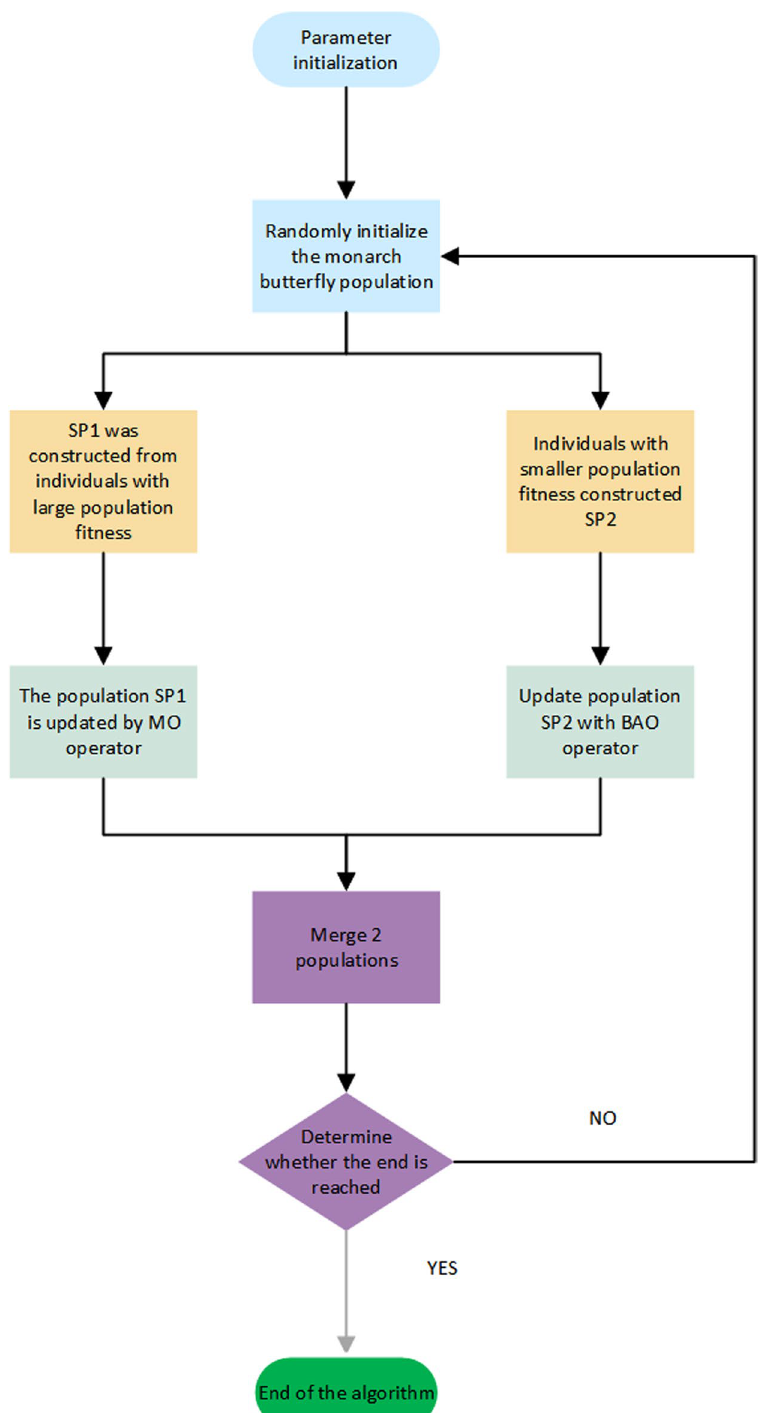
Fig. 3 Flowchart of the monarch butterfly